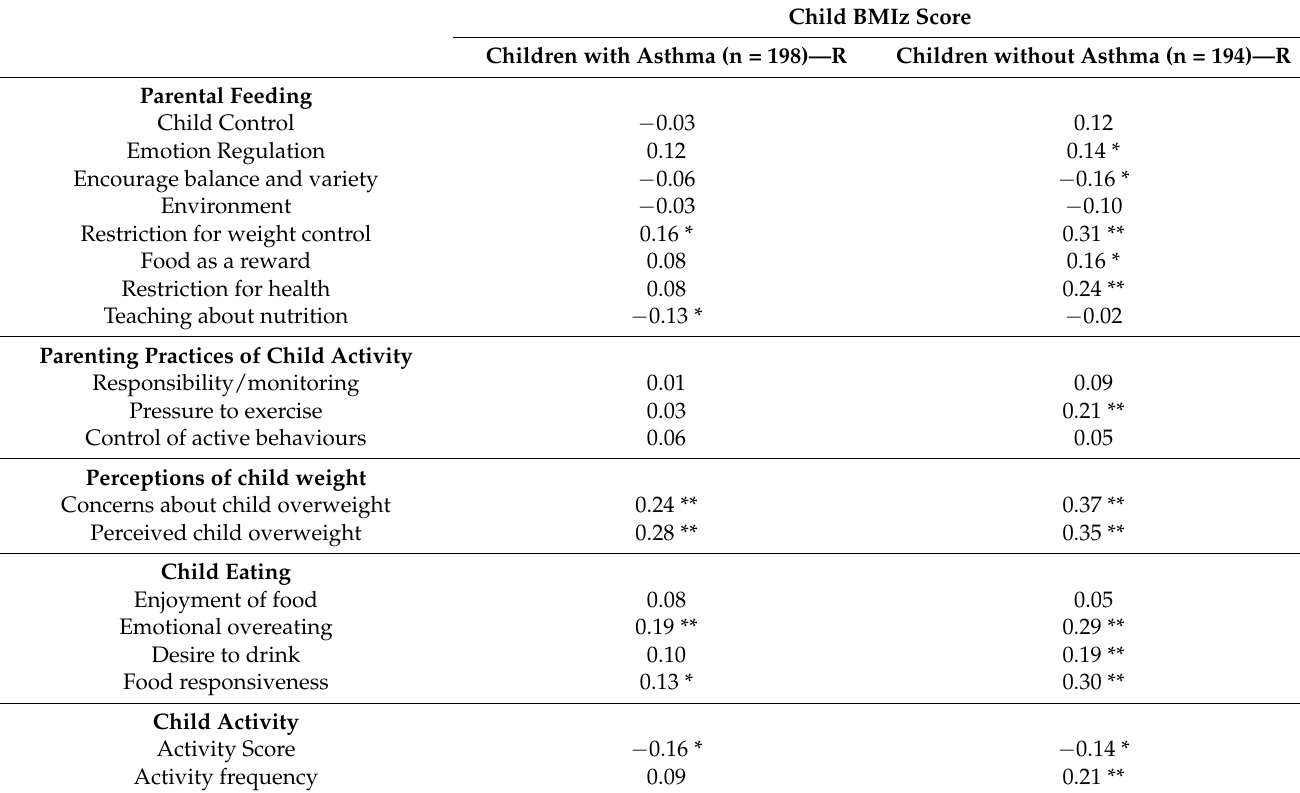
Table 4. Spearman’s Rho partial correlations correlating child BMIz score with parental feeding practices, parenting practices around child activity, parental concerns around child weight, child eating and child activity levels. Child BMIz Score Children with Asthma (n = 198)—R Children without Asthma (n = 194)—R − 0.03